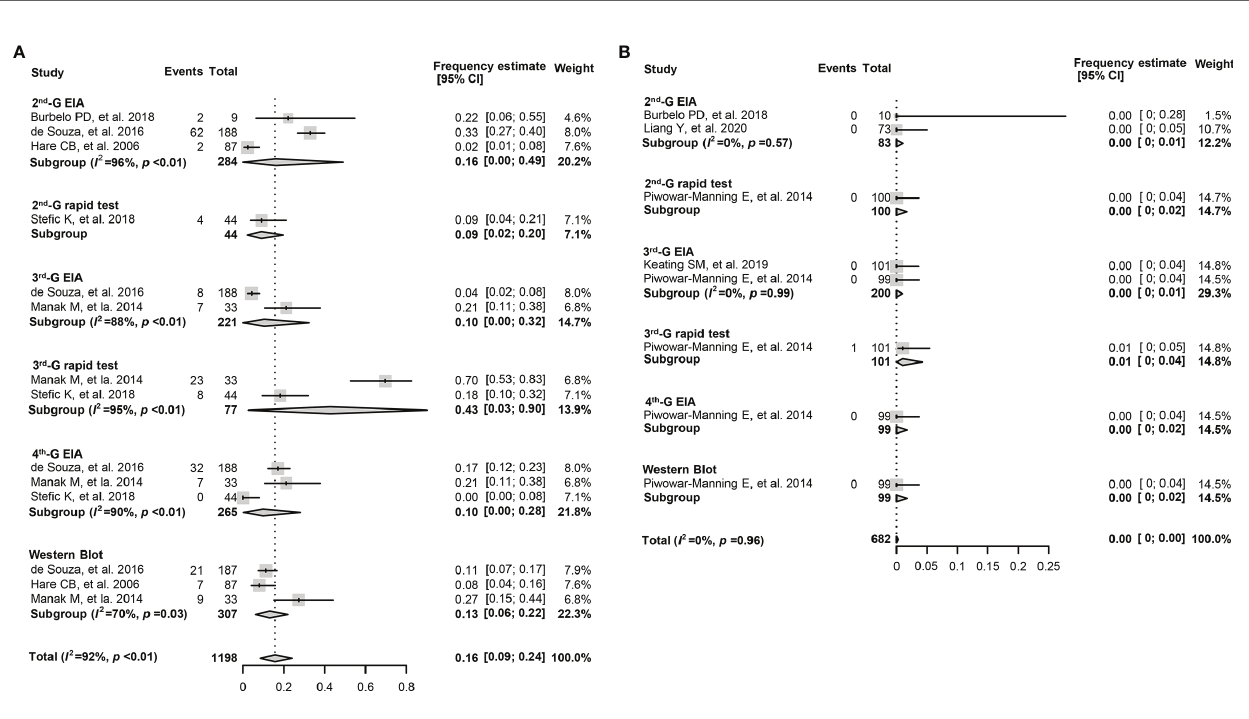
FIGURE 3 | Forest plots of the pooled frequency of HIV-1 seronegativity in HIV-infected adults according to the principles of HIV serological assays. (A) The pooled frequency of HIV-1 seronegativity in early-treated (<6 months post diagnosis) adult patients. (B) The pooled frequency of HIV-1 seronegativity in deferred-treated (>6